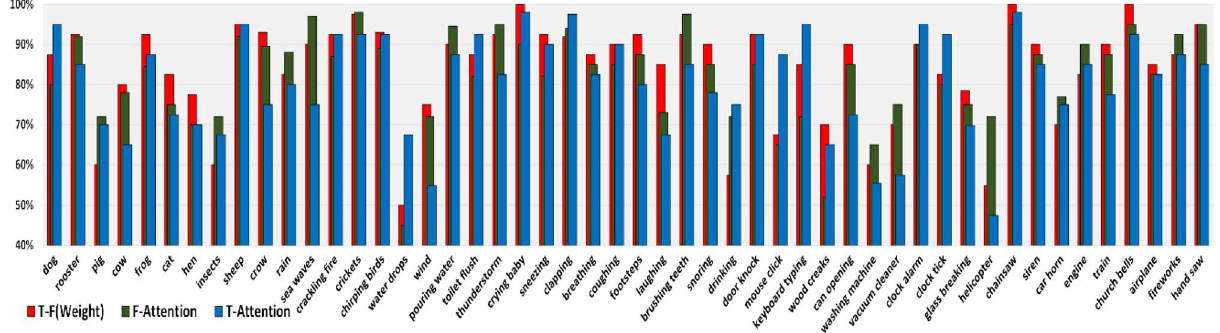
Figure 9. The classification accuracy of the TFCNN model on the ESC-50